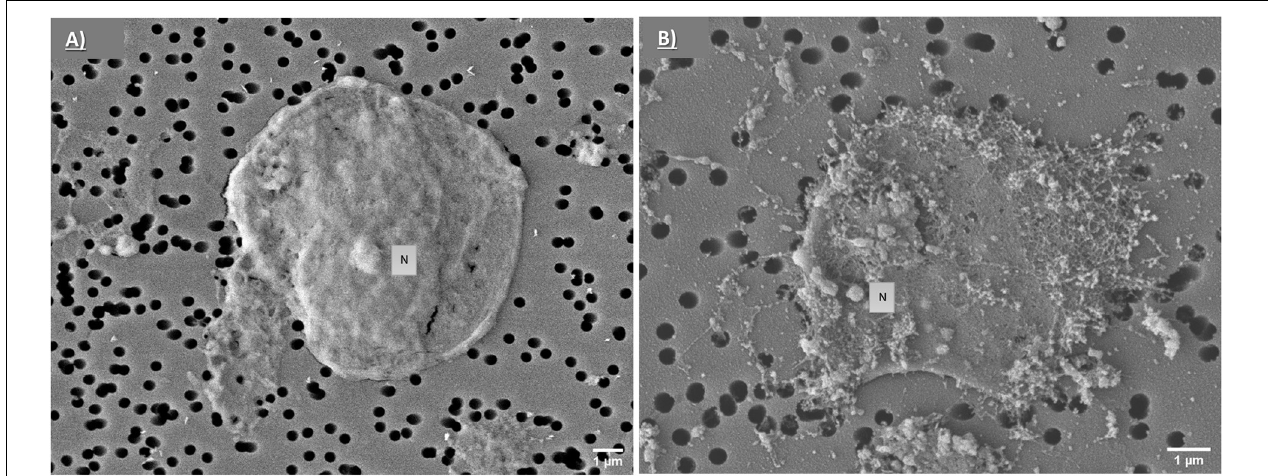
FIGURE 8 | SEM analysis of phagocytes. Representative SEM images of control phagocytes (exposed to CF only) (A) and after exposure to PS-COOH at 25 µ g mL − 1 (B) . SEM images acquired using a SEM JSM-6700F coupled to LEI detector. Scale bars: 1 µ m.